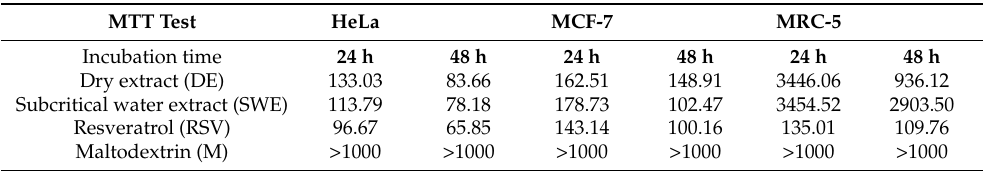
Figure 3. Cytotoxicity percentage determined by MTT test on MRC-5, after 24 h and 48 h exposures to V. vinifera extracts in a concentration ranging from 25 μg/mL to 125 μg/mL. (1) Dry extract — DE; (2) subcritical water extract — SWE; (3) resveratrol — RSV; (4) maltodextrin — M. Table 1. IC 50 values obtained by MTT test, after 24 h/48 h treatments of HeLa, MCF-7 and MRC-5 cells with dry extract, subcritical water extract, resveratrol and maltodextrin.